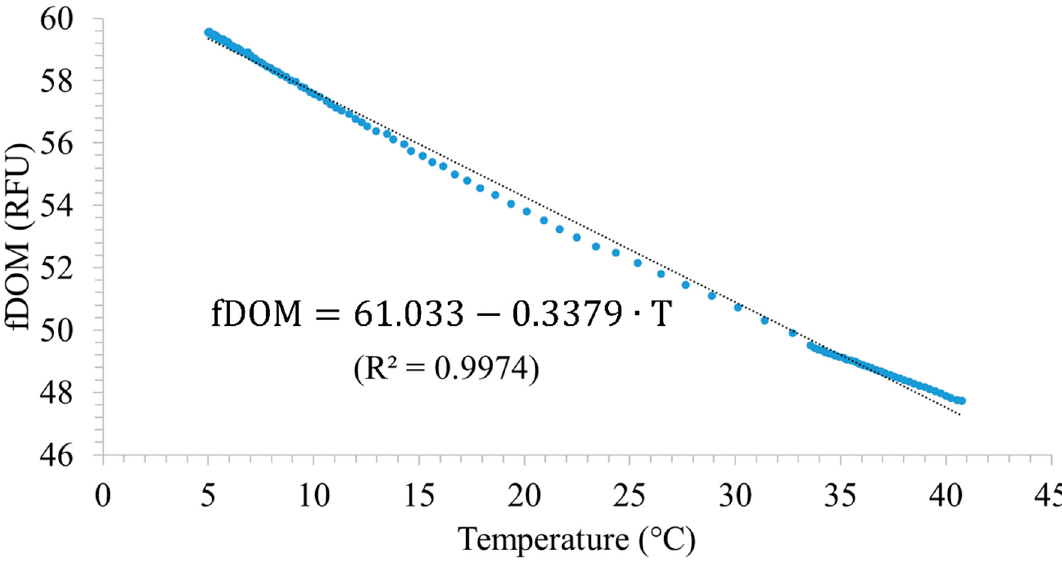
Figure 2. Linear regression of measured fDOM readings against temperature.